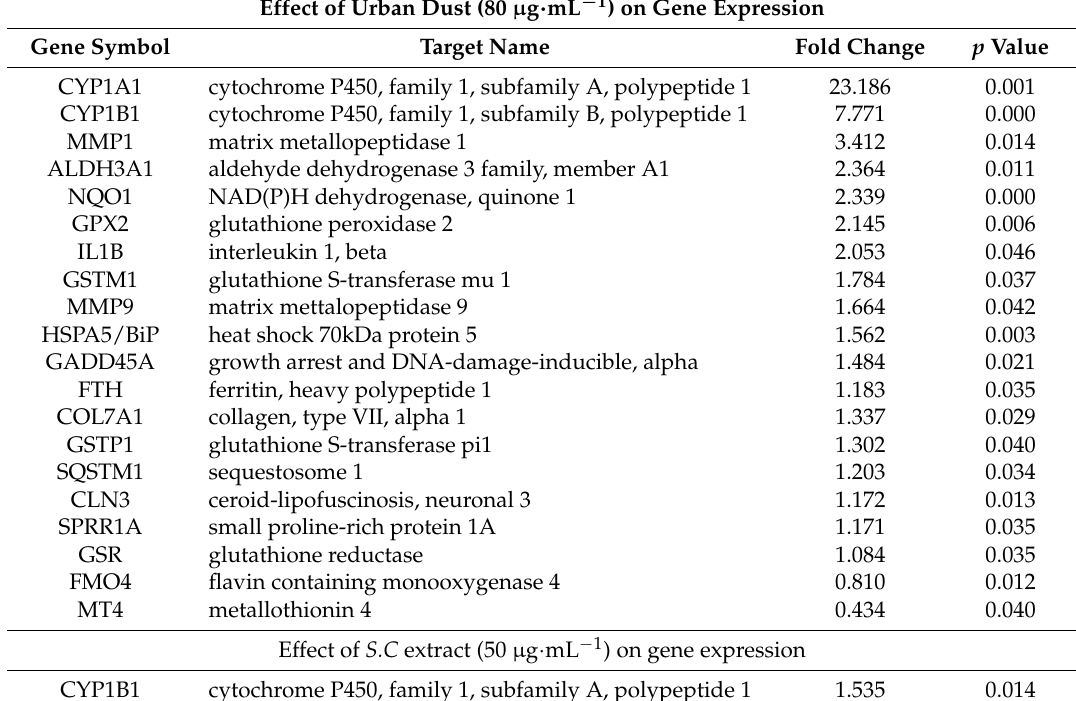
Table 1. The Effect of Urban Dust and S.C . extract on gene expression